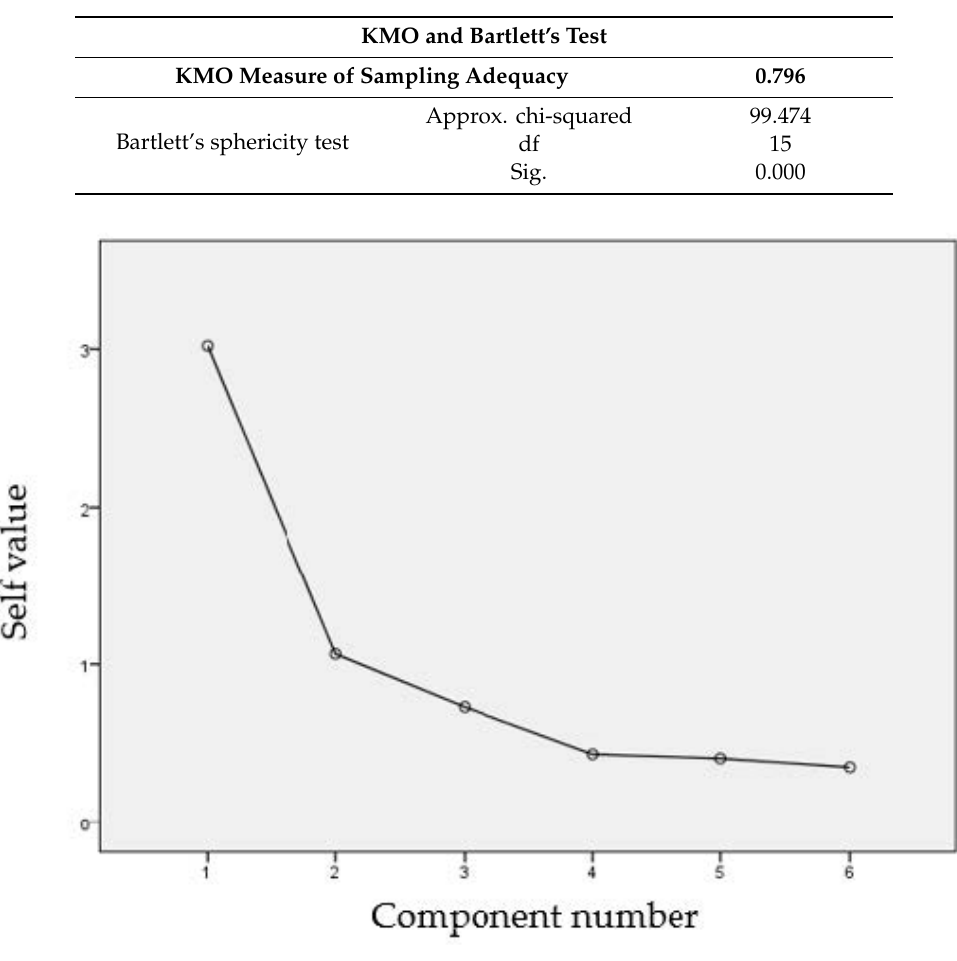
Figure 1. Scree plot.